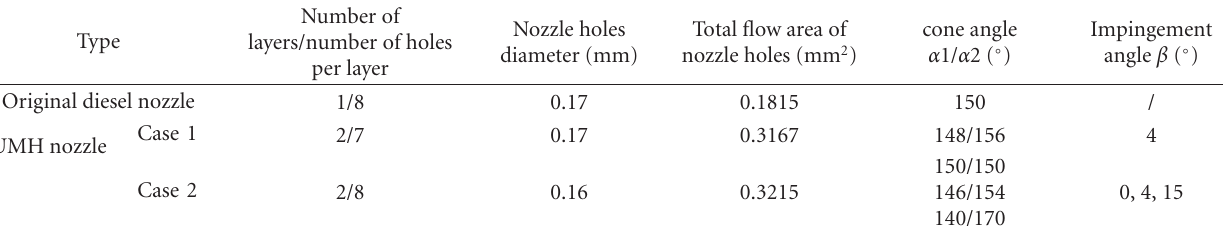
Table 2: Specifications of nozzles.